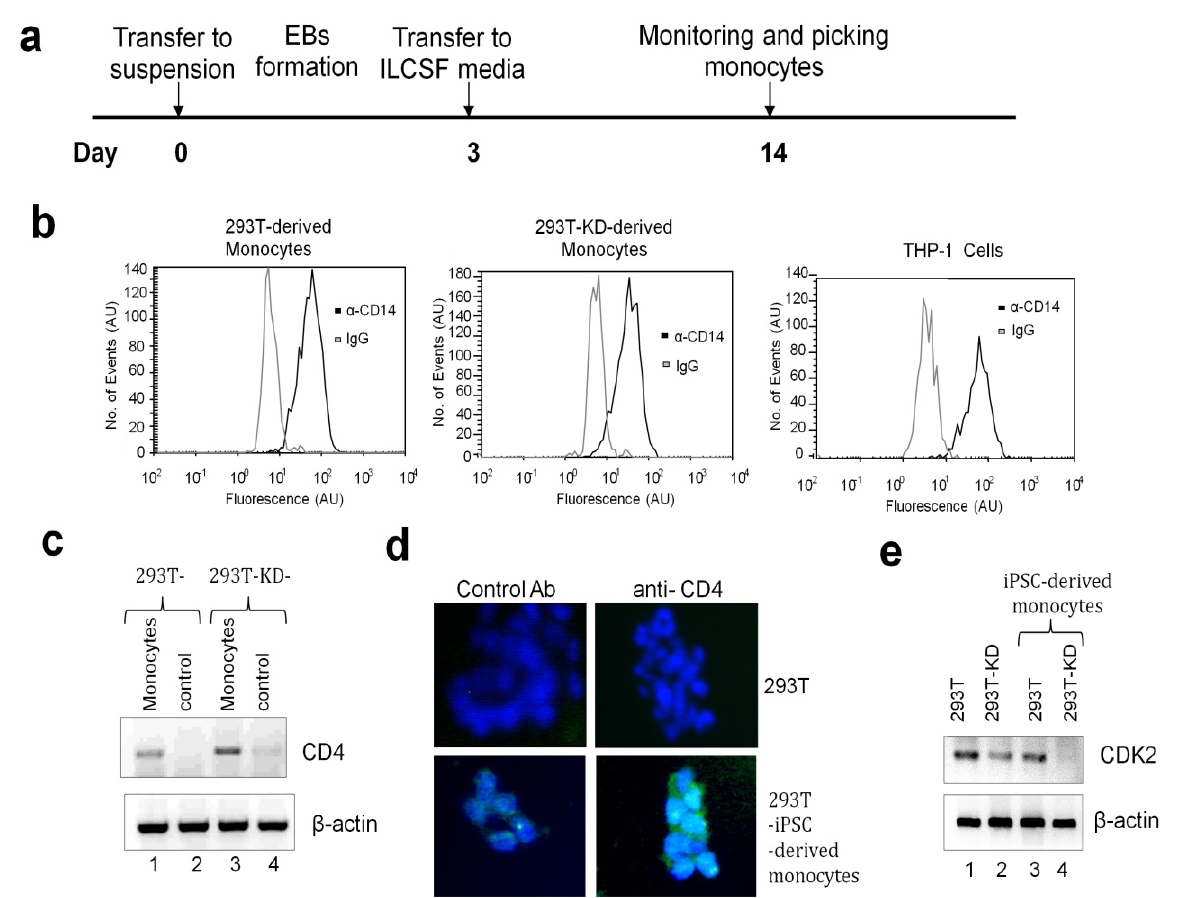
Figure 6. Differentiation of iPSC into monocytes. ( a ) A schematic diagram of the differentiation protocol ( b ) Analysis of CD14 expression in iPSC-derived monocytes. 293T iPSC-derived monocytes; 293T-KD iPSC (cid:177) derived monocytes and control THP-1 cells were stained with APC-linked antibodies against CD14 and analyzed by FACS. Solid line: the cells stained with CD14 antibodies, shadow line: cells stained with non-specific IgG linked to APC. ( c ) Analysis of CD4 expression in iPSC-derived monocytes. RNA was isolated from 293T-derived monocytes (lane 1), 293T cells (lane 2), 293T-KD derived monocytes (lane 3), 293T-KD cells (lane 4). The RNA was reverse transcribed and (cid:68)(cid:80)(cid:83)(cid:79)(cid:76)(cid:73)(cid:76)(cid:72)(cid:71)(cid:3) (cid:90)(cid:76)(cid:87)(cid:75)(cid:3) (cid:83)(cid:85)(cid:76)(cid:80)(cid:72)(cid:85)(cid:86)(cid:3) (cid:86)(cid:83)(cid:72)(cid:70)(cid:76)(cid:73)(cid:76)(cid:70)(cid:3) (cid:73)(cid:82)(cid:85)(cid:3) (cid:38)(cid:39)(cid:23)(cid:3) (cid:68)(cid:81)(cid:71)(cid:3) (cid:533) -actin as control. ( d ) Analysis of CD4 expression in iPSC-derived monocytes. Control 293T clls (upper panels) and the detached monocytes (lower panels) were fixed and immunostained with FITC-conjugated CD4 or non-specific mouse IgGs as indicated. Nuclei were counterstained with DAPI. ( e ) Analysis of CDK2 expression in iPSC-derived monocytes. RNA was isolated from 293T cells (lane 1), 293T-KD cells (lane 2), 293T-derived monocytes (lane 3) and 293T-KD derived monocytes (lane 4). The RNA was reverse transcribed and amplified with primers specific (cid:73)(cid:82)(cid:85)(cid:3)(cid:38)(cid:39)(cid:46)(cid:21)(cid:3)(cid:68)(cid:81)(cid:71)(cid:3)(cid:533) -actin as